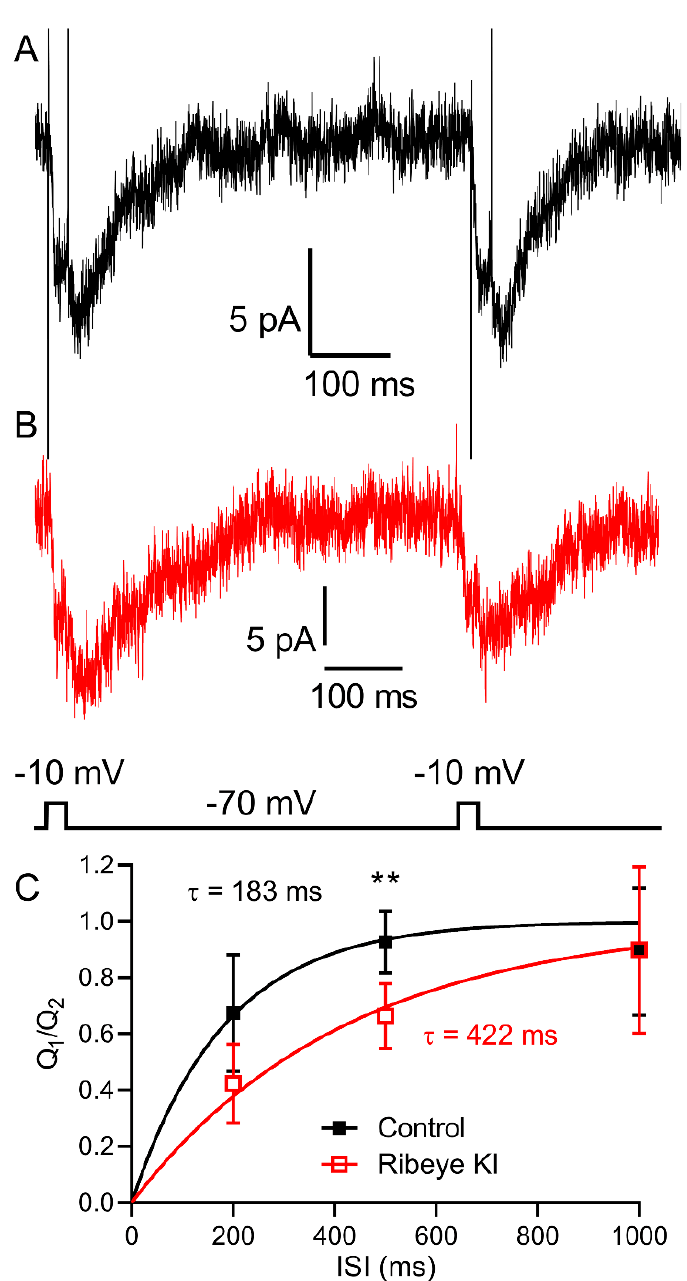
Figure 10. Loss of ribbons slowed down recovery from paired pulse depression in the rods assessed by measuring I A(glu) . Examples of I A(glu) recorded from a control C57Bl6 rod (( A ), black trace) and a Ribeye KI rod (( B ), red trace) that lack ribbons. The test steps in these examples were separated by 500 ms. ( C ). Amplitude of the I A(glu) charge transfer evoked in a rod by the second test step relative to the first response in each trial from both control (black squares, n = 8–10 rods at each datapoint) and Ribeye KI rods (open red squares, n = 9–12 rods from five mice). Individual values differed significantly at the 500 ms interval (**: p = 0.002, t -tests corrected for multiple comparisons). Recovery of the I A(glu) charge transfer from paired pulse depression was fit with a single exponential function. In the absence of ribbons, the time constant doubled ( p = 0.026; extra sum-of-squares F-test) from 183 ms in the C56Bl6 rods ( n = 10 rods; rate constant, K = 0.00547 ± 0.00102 ms, SEM) to 422 ms in the Ribeye KI rods ( n = 12; K = 0.002372 ± 0.000351 ms).